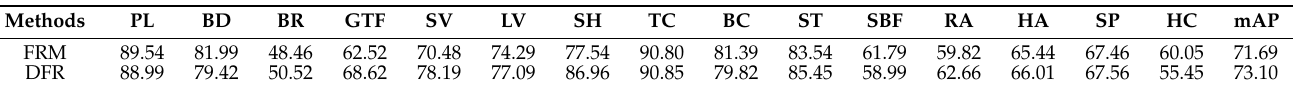
Table 2. Ablation study of FRM and the proposed DFR, where FRM is the original feature refinement module proposed by R 3